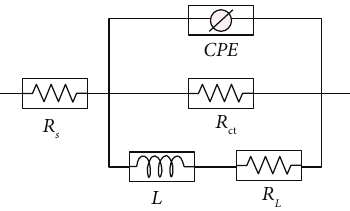
Figure 5: Equivalent circuit model proposed to match the EIS